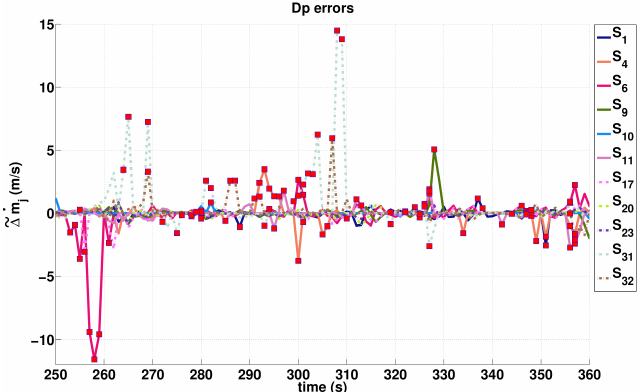
Figure 5. ˜ ∆ ˙ m j estimations on Doppler measurements acquired by the different satellites (numbered between 1 and 32). Red markers point out Dp outliers detected by